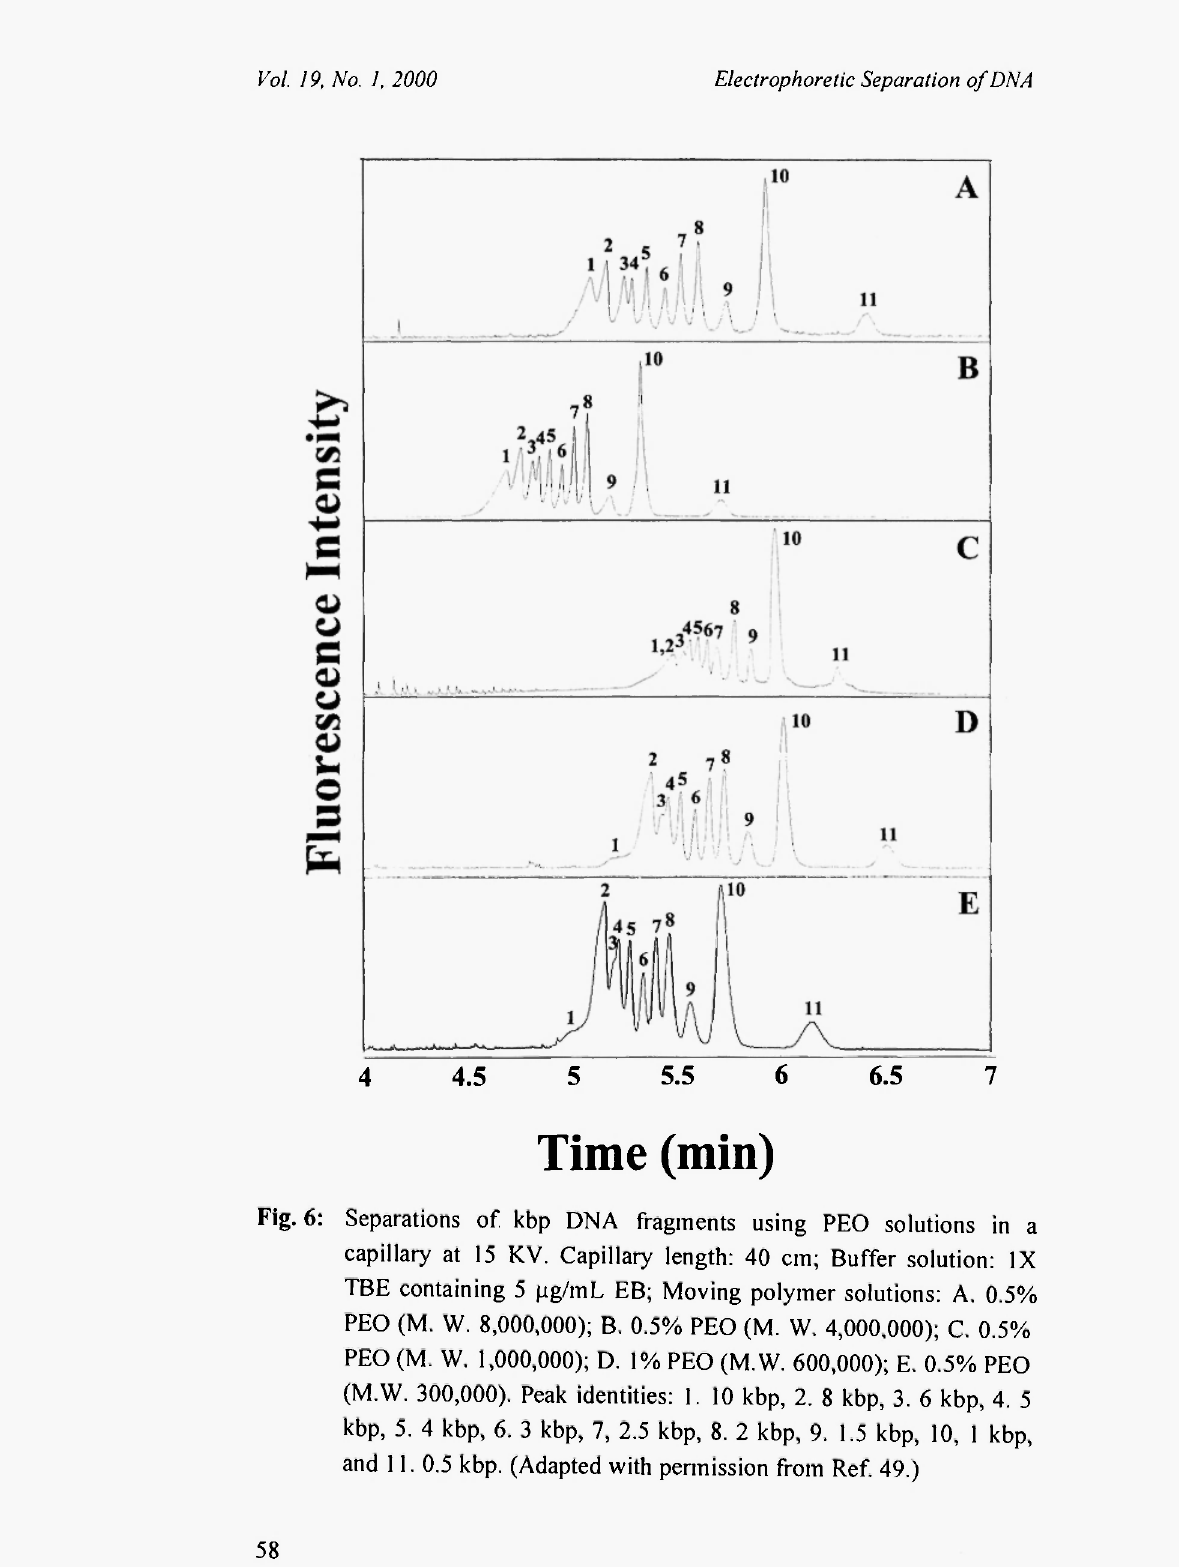
Fig. 6: Separations of kbp DNA fragments using PEO solutions in a capillary at 15 KV. Capillary length: 40 cm; Buffer solution: IX TBE containing 5 pg/mL EB; Moving polymer solutions: A. 0.5% PEO (M. W. 8,000,000); B. 0.5% PEO (M. W. 4,000,000); C. 0.5% PEO (M. W. 1,000,000); D. 1% PEO (M.W. 600,000); E. 0.5% PEO (M.W. 300,000). Peak identities: 1.10 kbp, 2. 8 kbp, 3. 6 kbp, 4. 5 kbp, 5. 4 kbp, 6. 3 kbp, 7, 2.5 kbp, 8. 2 kbp, 9. 1.5 kbp, 10, 1 kbp, and 11. 0.5 kbp. (Adapted with permission from Ref.